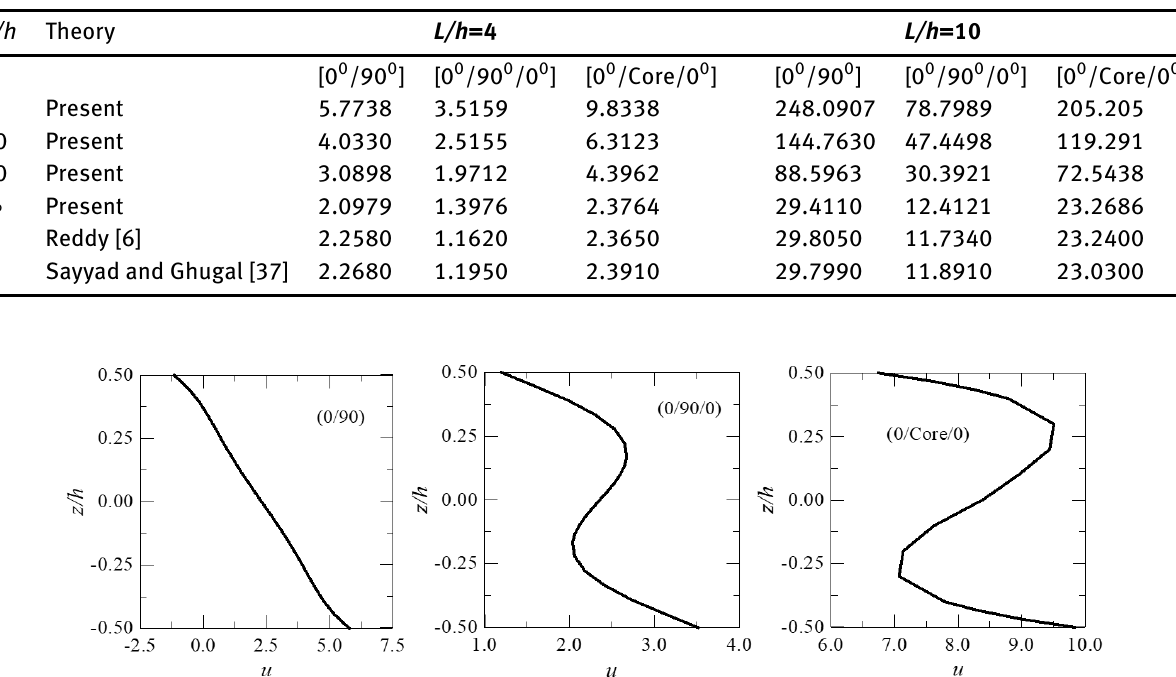
Table 3: Normalized axial displacement ( ¯ u ) of simply-supported laminated composite and sandwich curved beams.